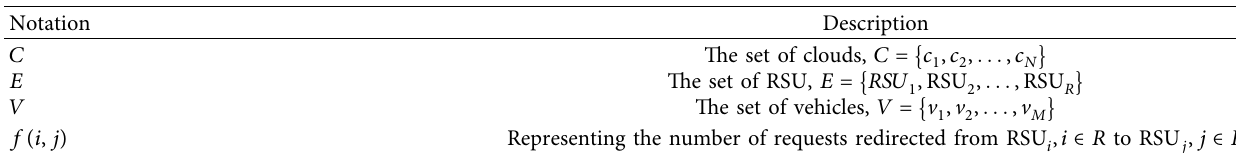
Table 2: Distribution of vehicular requests.